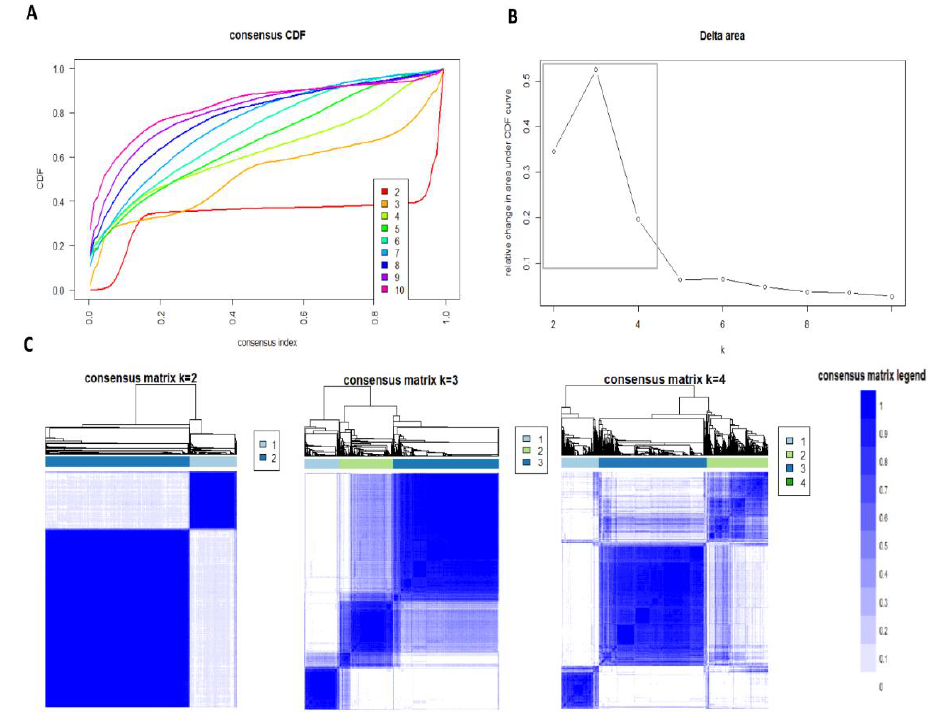
Figure 1. ( A ) CDF plot displaying consensus distributions for each k; ( B ) Delta area plot reflecting the relative changes in the area under the CDF curve. ( C ) Consensus matrix heat map depicting consensus values on a white to blue color scale of each cluster. The mean cluster consensus score was comparable between the scenario of two and three clusters (Figure 2A). Cluster 3 had more favorable low PACs by criteria than cluster 2 (Figure 2B). In summary, using baseline variables at hospital admission, the consensus clustering analysis identified 3 clusters that best represented the data pattern of our hos- pitalized hyponatremic patients.